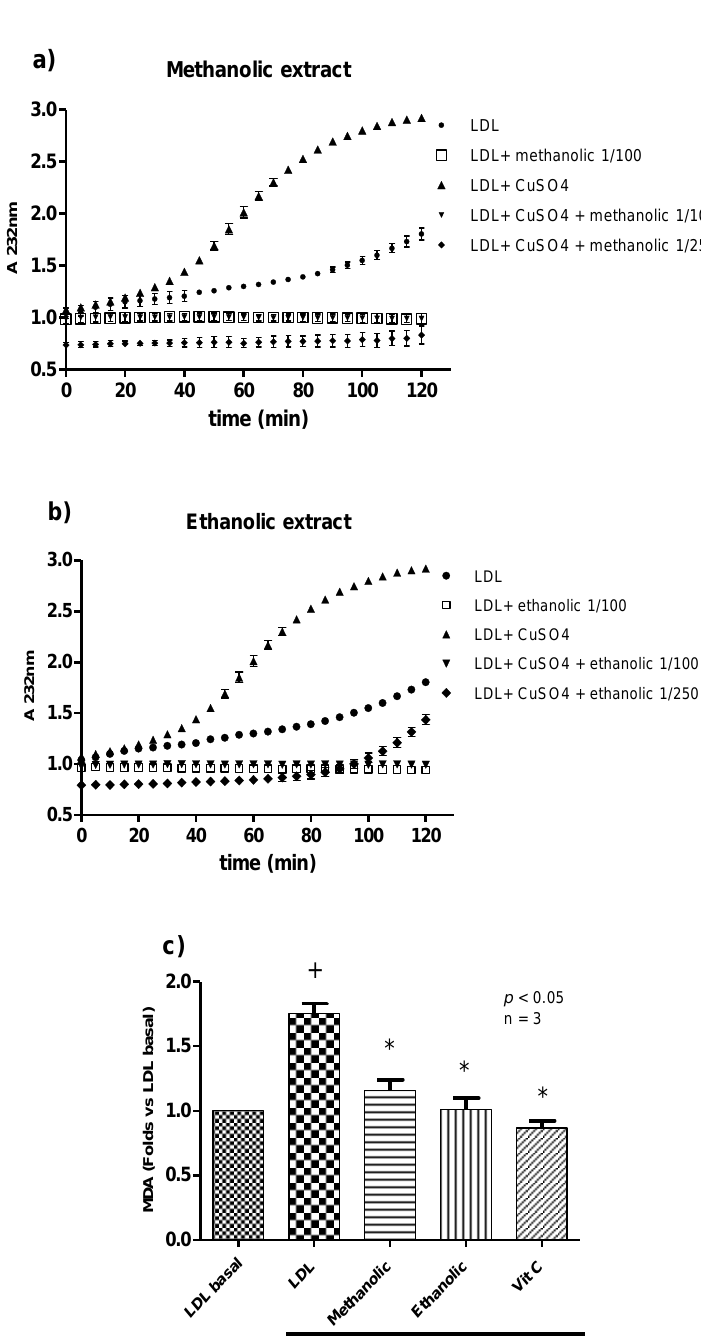
Figure 2. Effect of calafate extract on lipidic peroxidation of human low density lipoprotein (LDL). ( a ) Kinetic curve of LDL oxidation with or without methanolic extract (dilution 1/100 and 1/250). ( b ) Kinetic curve of LDL oxidation with or without ethanolic extract (dilution 1/100 and 1/250). Figures a and b are representative of three LDL assays obtained from different volunteers. ( c ) MDA production in relation to LDL basal control (methanolic and ethanolic extract dilution at 1/100). Data are presented as the mean ± standard error values. Vitamin C (250 µg/mL) was used as the antioxidant control. + p < 0.05 vs. LDL basal (negative control). * p < 0.05 vs. LDL CuSO 4 control (positive control).